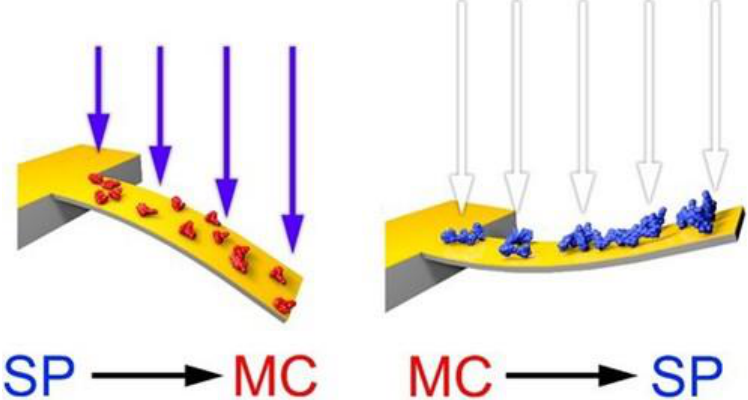
Figure 3. Schematic representation of deflection of SP functionalized cantilever when changing state form the SP to the MC form and vice versa.